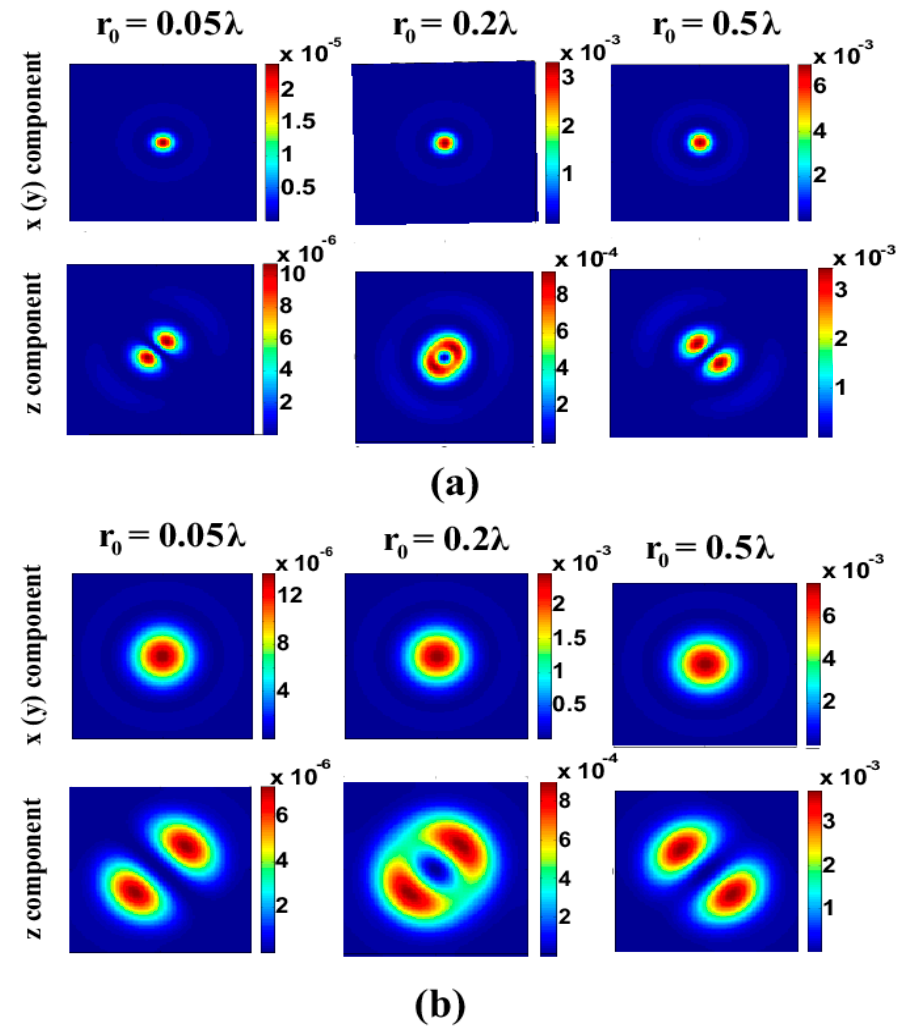
Figure 3. (Color online) Intensity patterns of x -, y - and z - components with different radial periods of initial SoP alignments (i.e., different r 0 in this work) and w =0.1 λ : ( a ) the evanescent wave; ( b ) the propagation wave. Upper plots in ( a , b ) transverse ( x or y ) component; lower plots in ( a , b ) z component. All the images have the same dimension of 2 × 2 λ 2 .